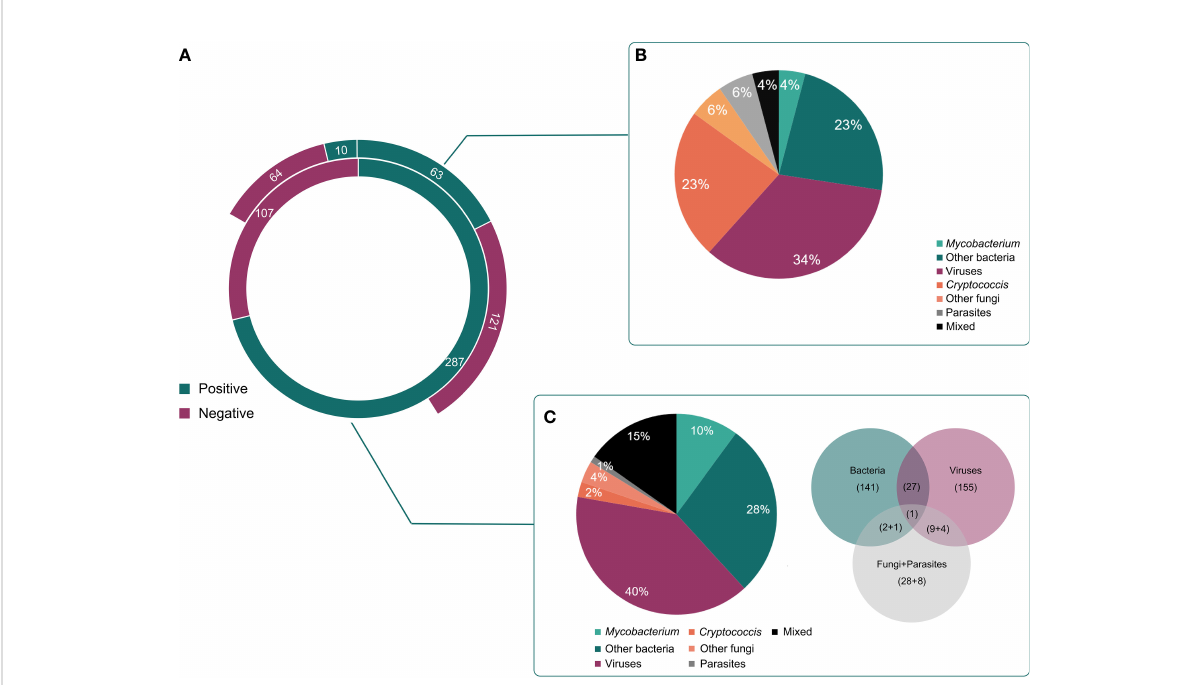
FIGURE 3 Different kinds of infections by mNGS and conventional methods. (A) , The detected results of mNGS and conventional methods in all enrolled patients. (B) , Different kinds of infections in positive cases detected by conventional methods. (C) , Different kinds of infections in positive cases detected by mNGS.